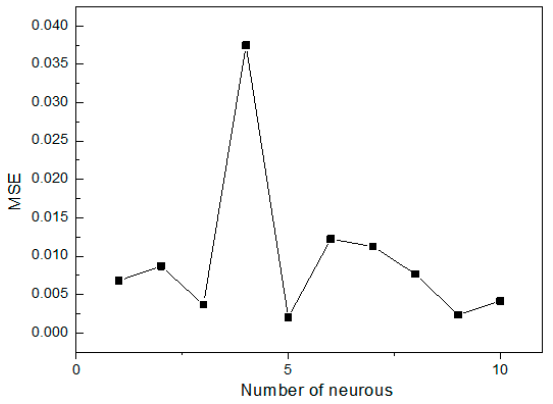
Figure 5. Effect of neuron number on the performance of ANN using mean squared error ( MSE ) as a criterion.